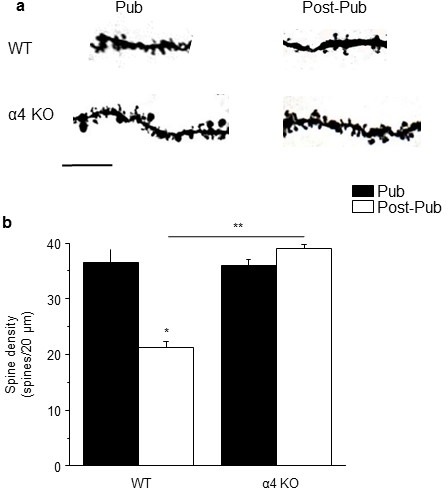
Synaptic pruning of CA1 hippocampus of adolescent male mice is prevented in the α4 knock-out.Pub, pubertal; post-Pub, post-pubertal. (a) CA1 hippocampal pyramidal cells, Pub and post-Pub (8-week old) WT and α4 KO male mouse hippocampus. (a) Representative z-stack (100x) images; scale, 5 µm. (b) Averaged data for spine density, WT, pub vs. post-pub, t-test, t(22)=5.84, p<0.0001*, power=1; n= 12 neurons (3 mice)/group; α4 KO, pub vs. post-pub, t-test, t(22)=2, P=0.97; n= 12 neurons (3 mice)/group; post-pub, WT vs. α4 KO, t-test, t(22)=12.5, p<0.0001*, power=1. *p<0.05 vs. Pub; **p<0.05 vs. WT. (Source data 1)DOI:
http://dx.doi.org/10.7554/eLife.15106.00810.7554/eLife.15106.009Figure 1—figure supplement 2—source data 1.Spine counts/20 μm on dendrites of CA1 hippocampal pyramidal cells for Figure 1b for wild-type (WT) and α4 knock-out (KO) male mice assessed at puberty (Pub, PND 35) and post-puberty (Post-pub, PND 56).